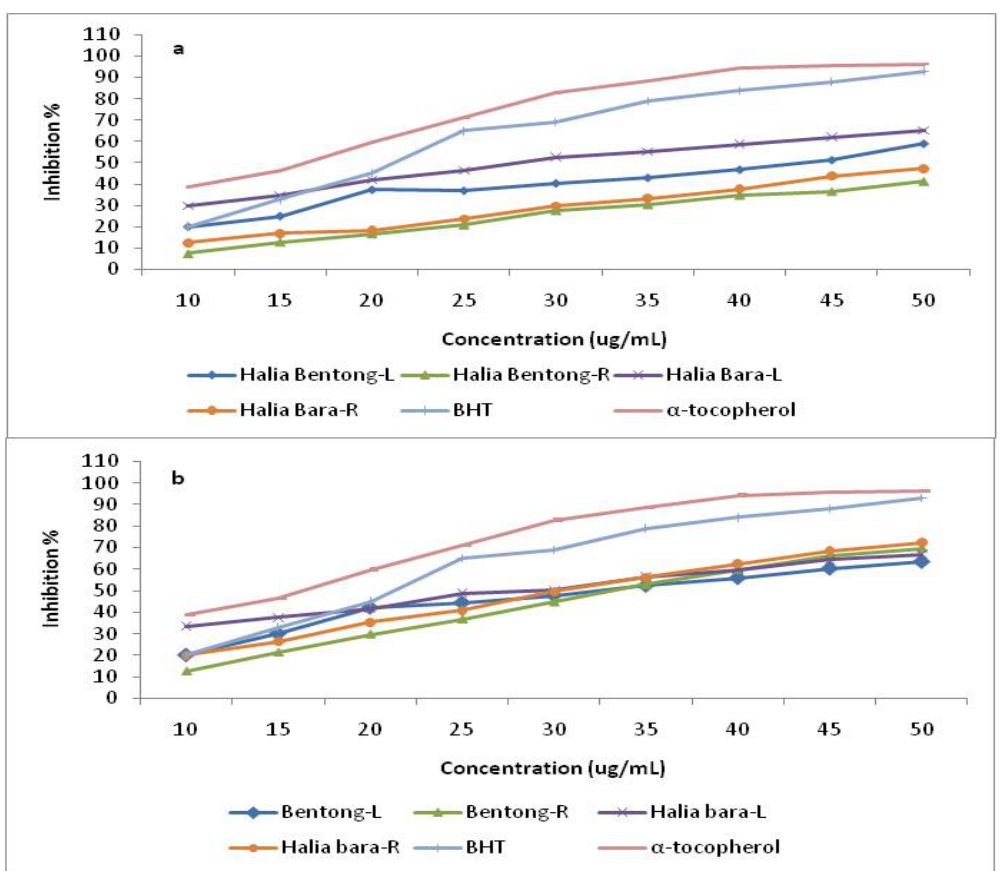
Figure 4. DPPH radical scavenging activity of the methanolic extracts in different parts of two varieties of Zingiber officinale compared with positive controls butylated hydroxytoluene (BHT) and α -tocopherol. L and R represent the leaves and rhizomes at